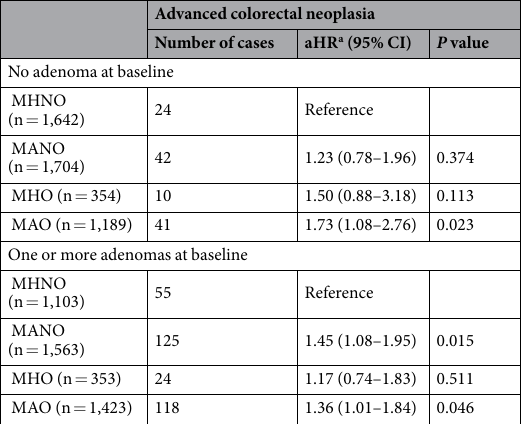
Table 3. The risk of metachronous advanced colorectal neoplasia by metabolic status and obesity using body mass index in subgroups with or without adenomas at baseline. a Estimated from Cox proportional hazard models adjusted for age, sex, smoking status, alcohol intake, regular exercise, regular aspirin use, family history of colorectal cancer, and high risk adenoma at screening colonoscopy. aHR, adjusted hazard ratio; CI, confidence interval; BMI, body mass index; MHNO, metabolically healthy non-obese; MANO, metabolically abnormal non-obese; MHO, metabolically healthy obese; MAO, metabolically abnormal